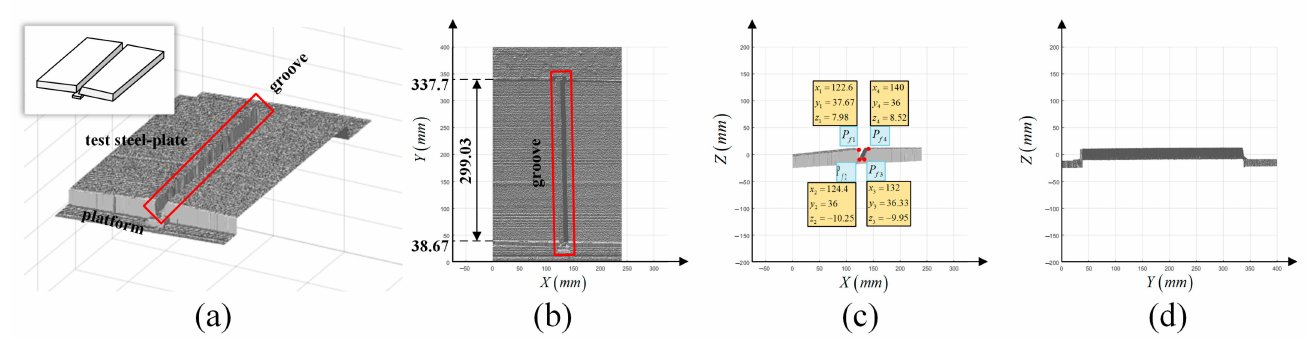
Figure 8. ( a ) Three-dimension reconstruction model of the test steel plate. The gray surface is the reconstructed three-dimension steel plate. The three-dimension model is displayed in the upper-left corner. ( b – d ) Projection of the model on plane XOY , XOZ , YOZ